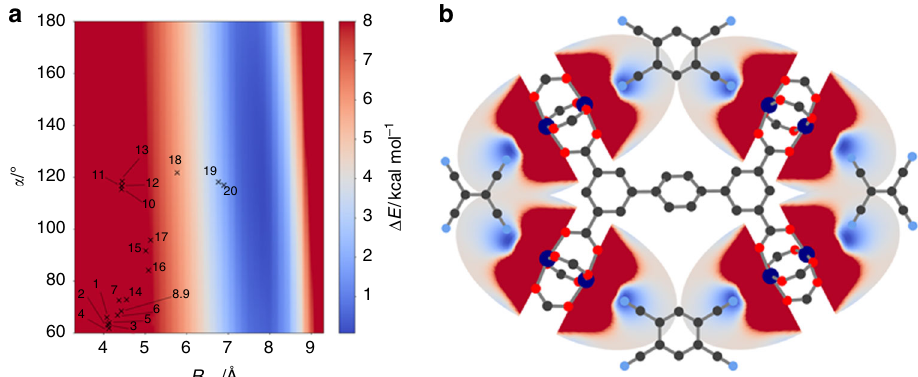
Fig. 7 RetroFit results for NOTT-101. a RetroFit map for the 3,3 ″ -position and the CL library (Fig. 3). Values of Δ E , which exceed the color scale bar are set to 8 kcal mol − 1 for better visualization. The lowest Δ E for the 3,3 ″ -position is obtained for CL 20 (TCNB, meta position), although CLs with even larger R NN distances will show better fi t. b Visualization of the implications for retro fi tting NOTT-101. It is conceivable that two different CLs can be installed in NOTT- 101, e.g., TCNB in the 3,3 ″ -position and TCNE in the 3,5-position. Cu, C, N, and O atoms are shown in dark blue, black, blue, and red. The potential around the OMSs is illustrated as Δ E increasing from blue to red